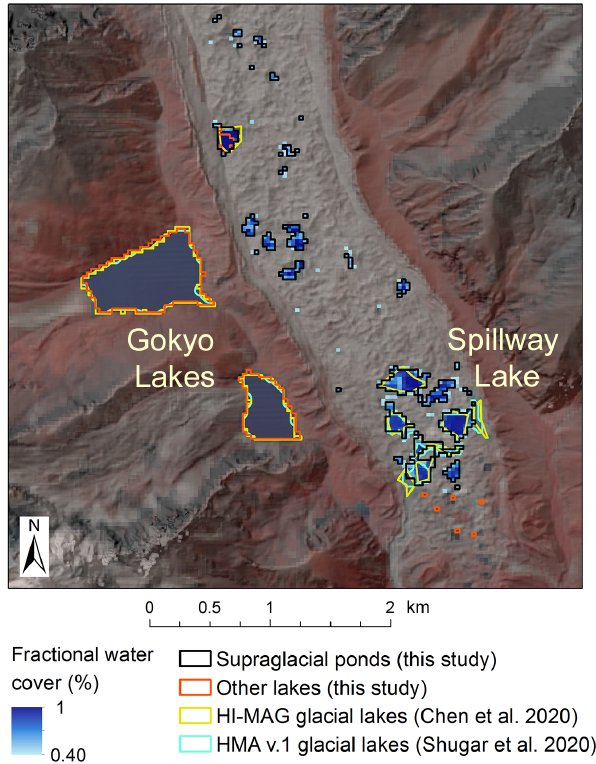
Figure 7. Comparison of the fractional ponds from this study with two recent lake datasets based on 2015 Landsat imagery (same as our study) for the Spillway Lake at the terminus of Ngozumpa Glacier and the Gokyo Lakes, with the Landsat colour composite of bands 5, 4 and 3 overlaid on shaded relief.